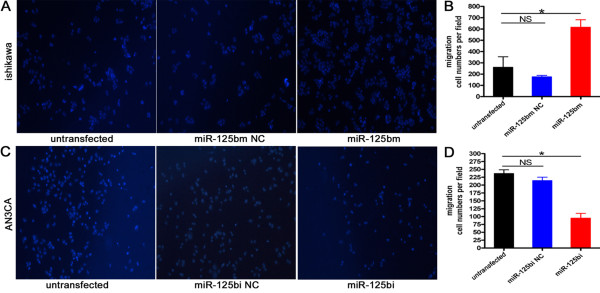
MiR-125b enhanced the mobility ability of EC cells using transwell migration assay. A. ishkawa cells were seeded in transwell filter. Migrated cells on the lower surface of the transwell filter were stained and counted after 24 h. Photographs were taken at 24 h post-migration (magnification, 100×). B. The numbers of migrated cells of ishikawa. Bars show mean ± SD. All experiments were repeated three times. *P < 0.01 vs. miR-125bm NC, untransfected. C. AN3CA cells seeded in transwell filter. Migrated cells on the lower surface of the transwell filter were stained and counted after 24 h. photographs were taken at 24 h post-migration (magnification, 100×). D. The numbers of migrated cells of AN3CA. Bars show mean ± SD. All experiments were repeated three times. *P < 0.01 vs. miR-125bi NC, untransfected.